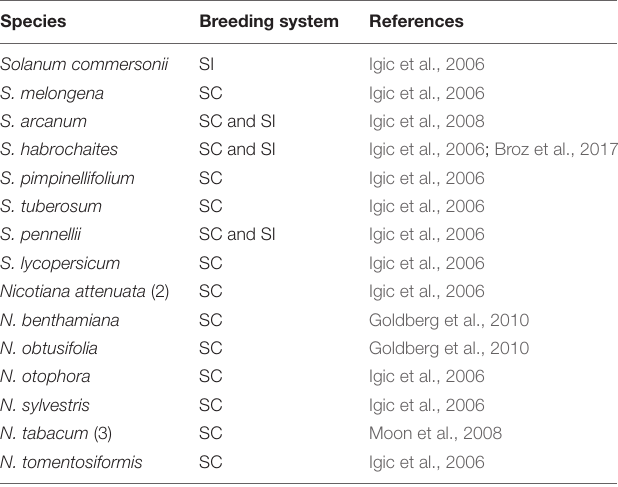
TABLE 1 | Breeding system for the species used in this work. Species Breeding